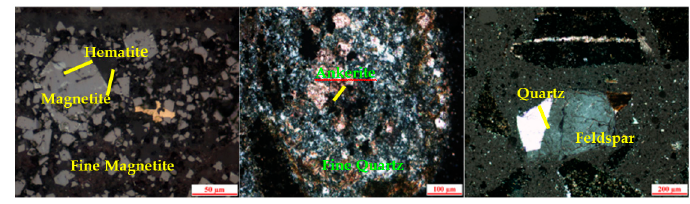
Figure 1. Optical microscope images of simples.